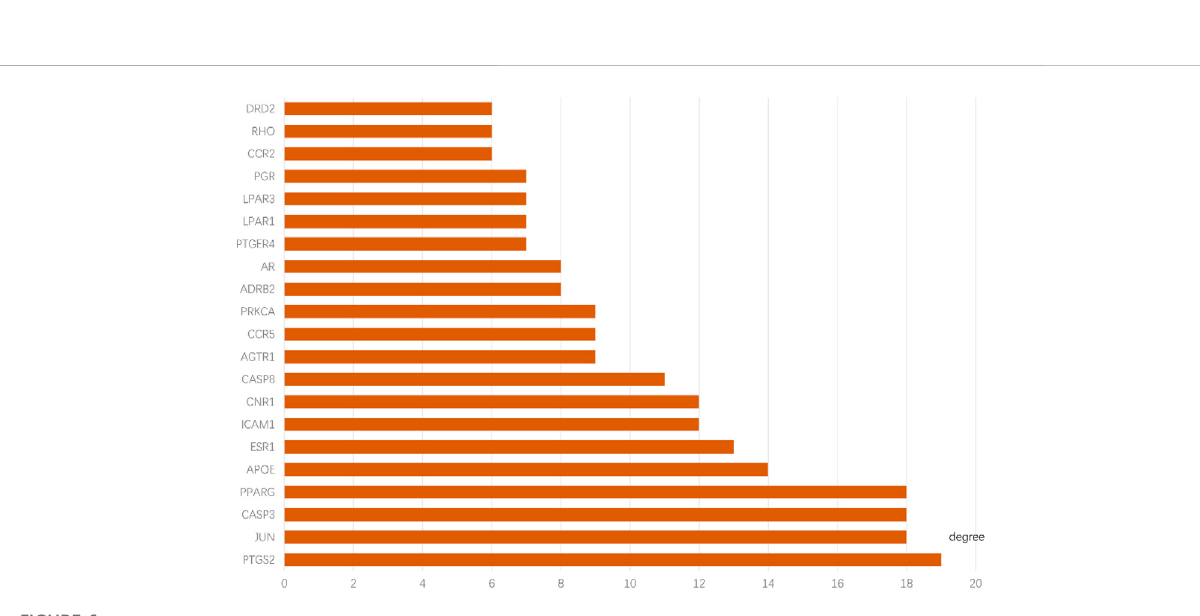
Frontiers in Molecular